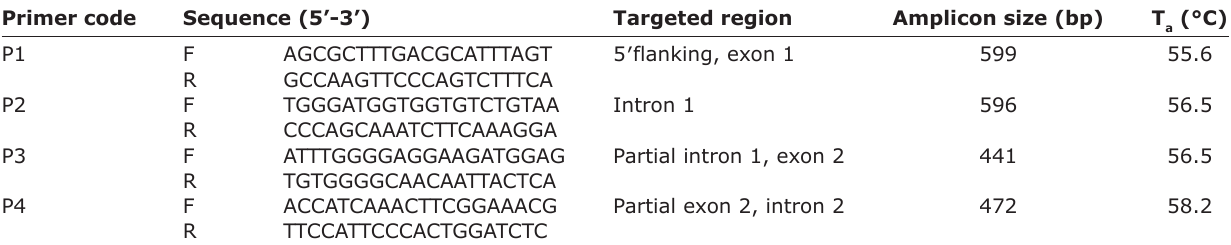
Table-1: Sequence of the primers designed for amplification of targeted region of PPP1R11 gene in Murrah bulls. Primer